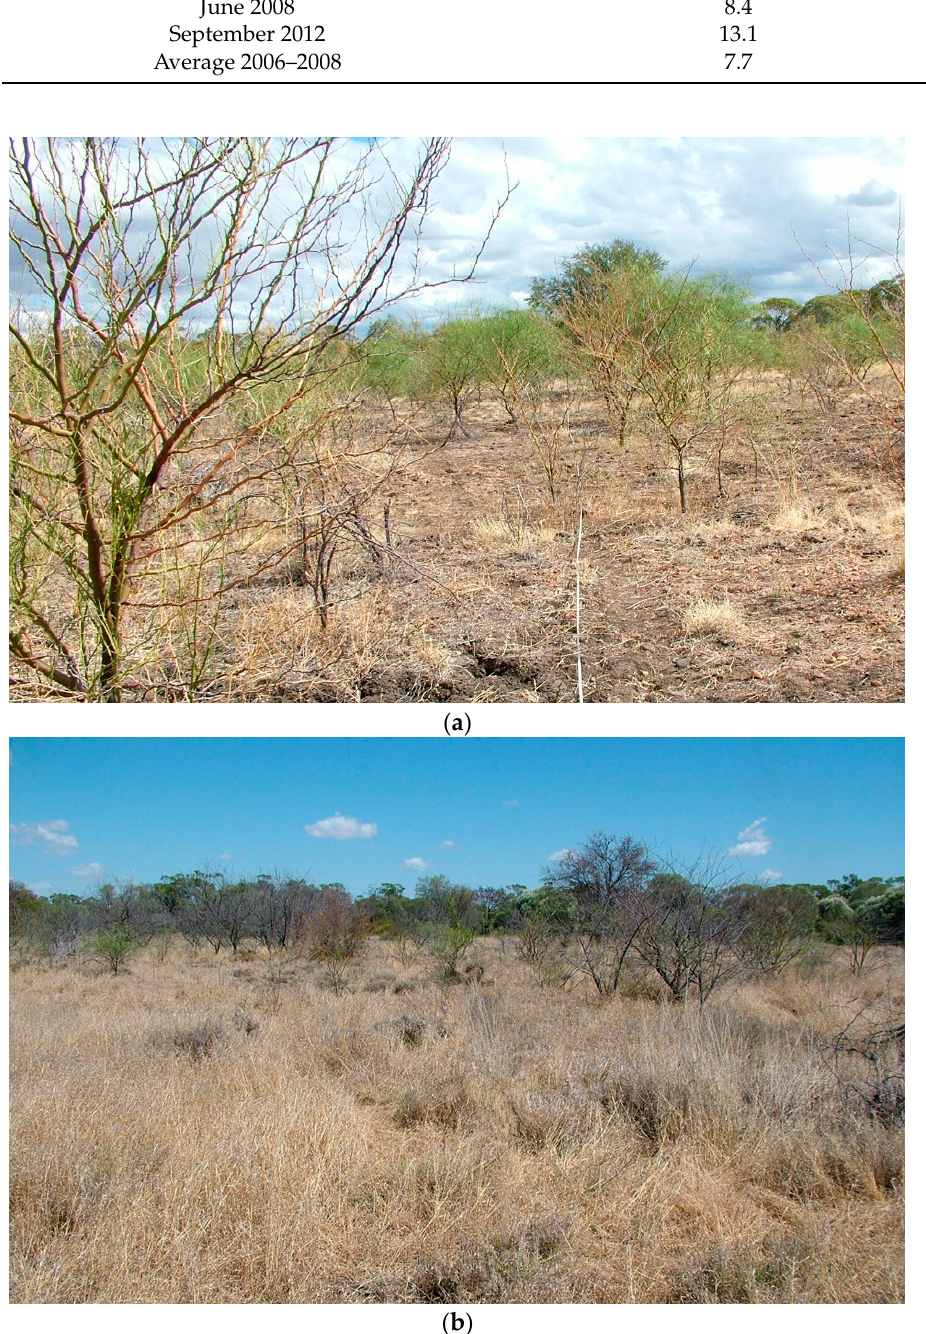
Figure 6 . Transect 2 viewed at 0 m (start of transect) at establishment in 2005 ( a ); and final assessment in 2012 ( b ). Note the reduced parkinsonia population (light-green foliage) in the second photograph.